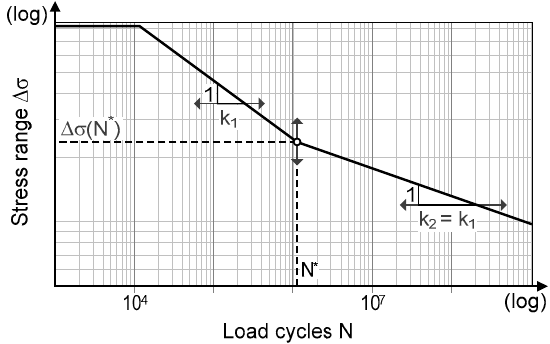
Figure 4. Typical S – N curve for high-strength steel and its variables indicated by arrows.